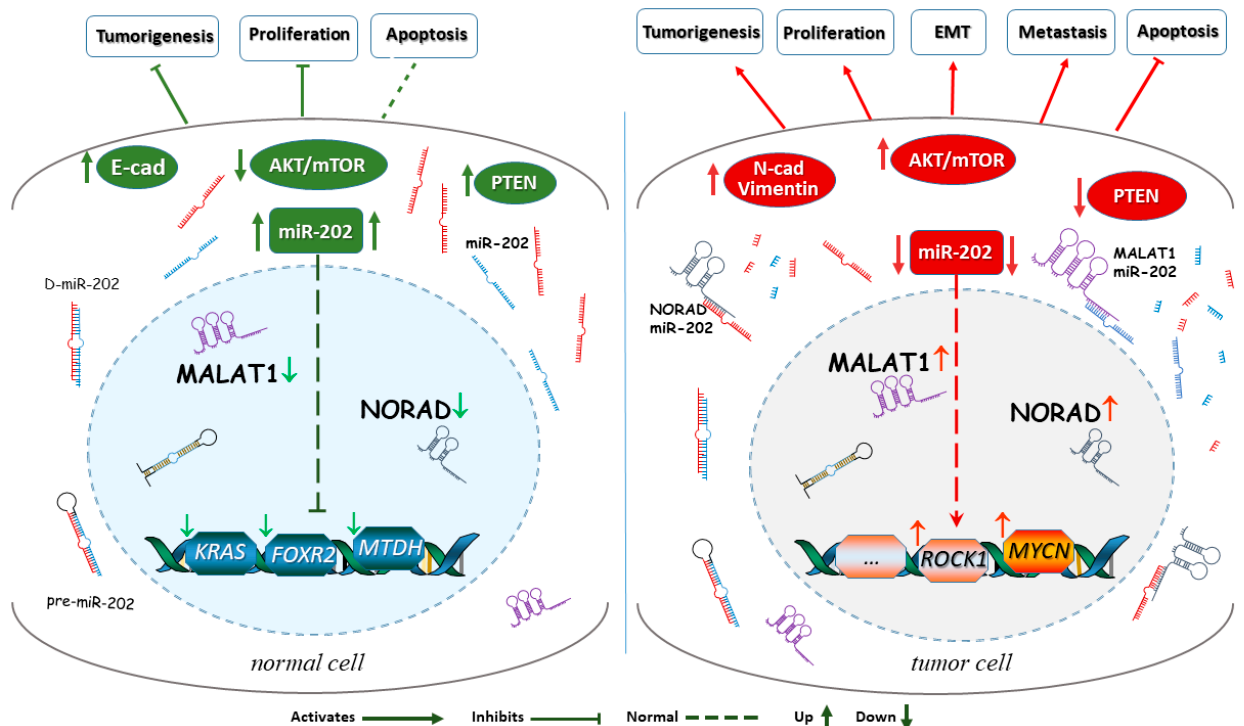
Figure 1. Downstream and upstream signaling involved in miR-202 ′ s suppressor functions. A simplified scheme of the complex circuitry around miR-202 in normal and in cancer cells. In a normal cell (left detail), the lncRNAs like MALAT1 and NORAD and oncogenes display low expression levels, allowing higher levels of miR-202, which prevents an increased expression of tumor promoting genes, such as KRAS, FOXR2, and MTDH , and allows miR-202 to act on other downstream target molecules. miR-202 is also important for normal activation and phosphorylation events in the AKT pathway. In the cancer cell (right detail), the lncRNAs MALAT1 and NORAD as well as oncogenes reduce miR-202 expression leading to miR-202 ′ s degradation and upregulation of cancer-promoting pathways as well as downregulation of apoptosis, which fuels tumor progression.